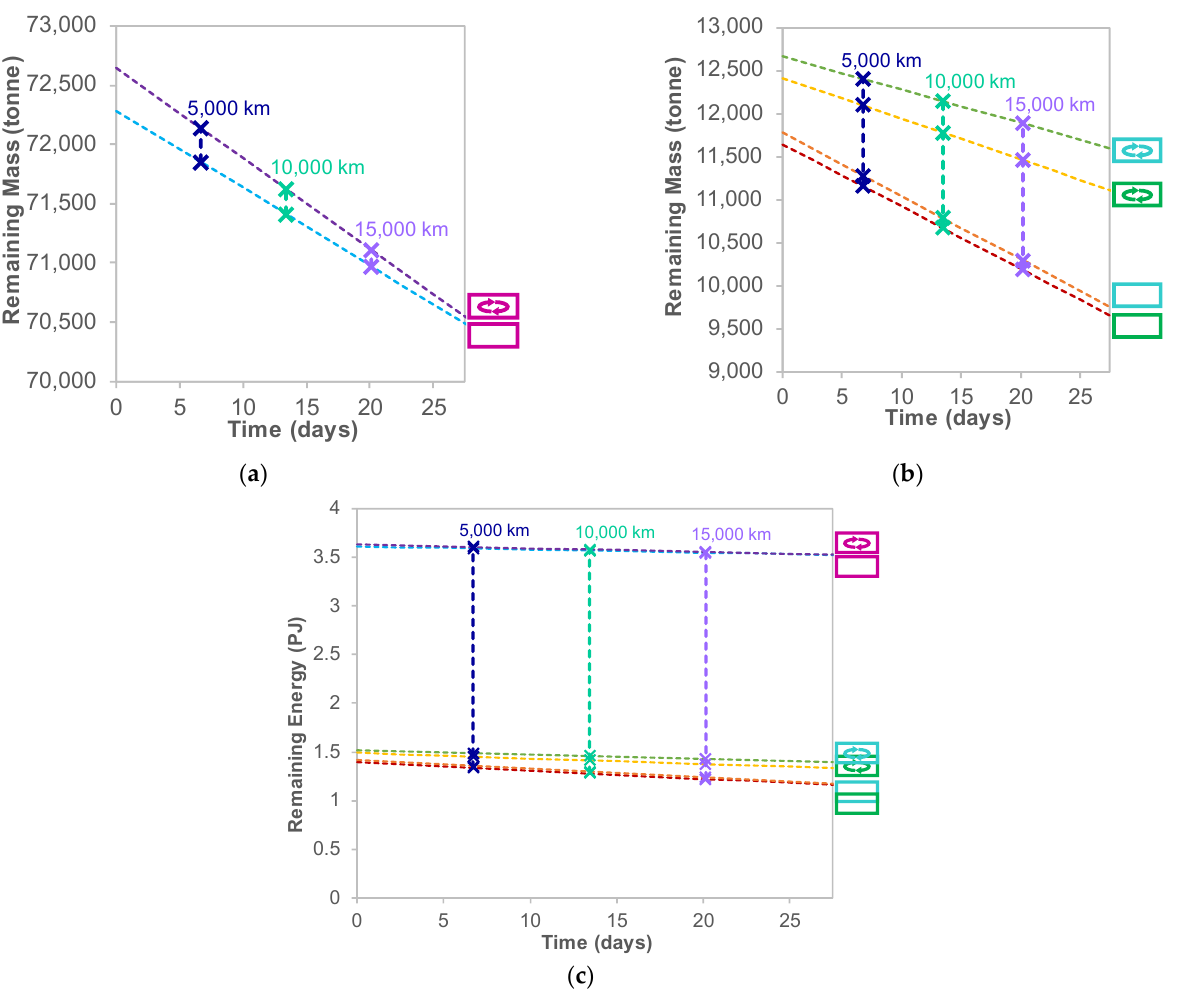
Figure 7. Variation of remaining fuel mass and energy with voyage duration at BN = 2 and a ship velocity of 16.7 knots. All investigated ships are shown at the insulation thickness that maximises the fuel delivered after a voyage of 20 days. The trends shown are ( a ) the remaining mass onboard all LNG ships; ( b ) the remaining mass onboard all LH2 ships; ( c ) the remaining energy onboard all investigated ships.